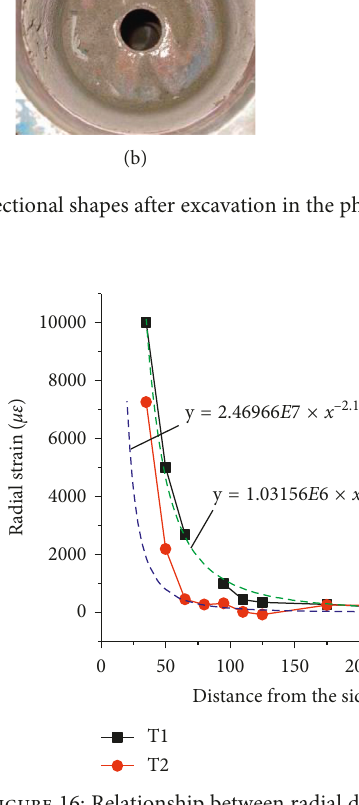
Figure 16: Relationship between radial displacement and distance from the side